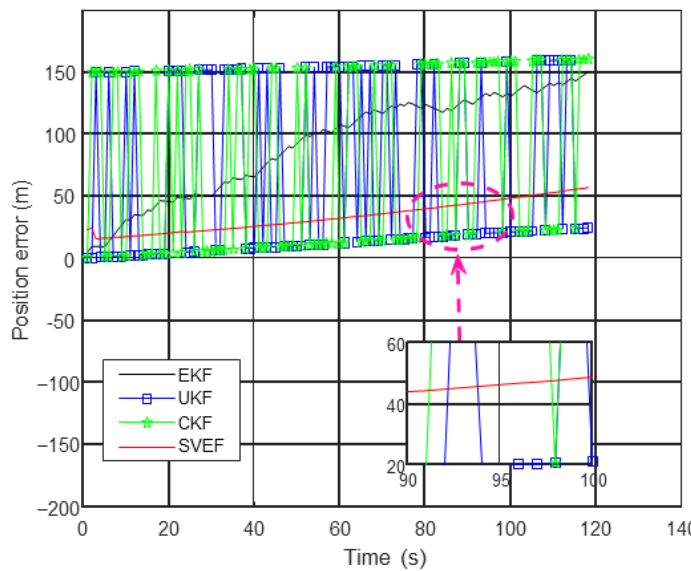
Figure 7. Position errors for different algorithms.